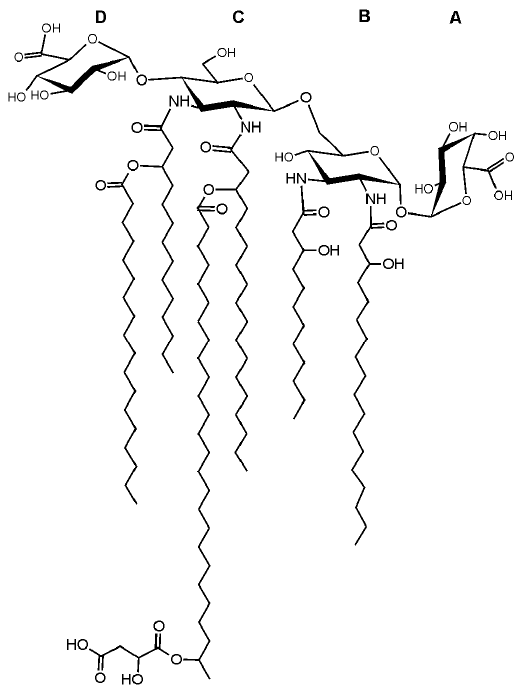
Figure 4. MALDI-TOF MS/MS spectrum of the parent ion at m/z 2478.775 (heptaacylated lipid A of O. carboxidovorans ). Peaks between m/z 1600 and 2400 are magnified five times. Ions marked in red are discussed in the text.